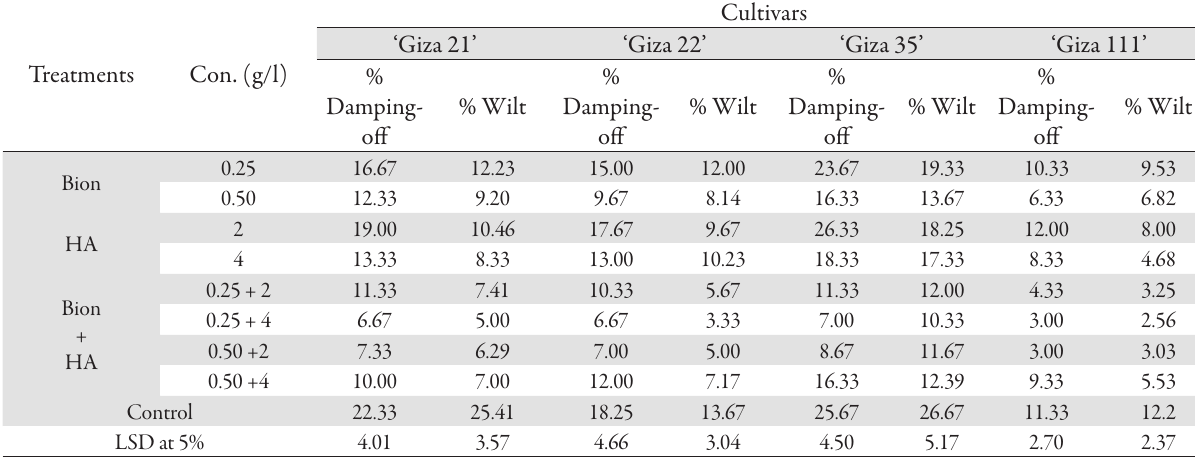
Tab. 4. Effect of BTH and HA on damping-off and wilt diseases of the four soybean cultivars under field conditions in Minia governorate at summer season 2010